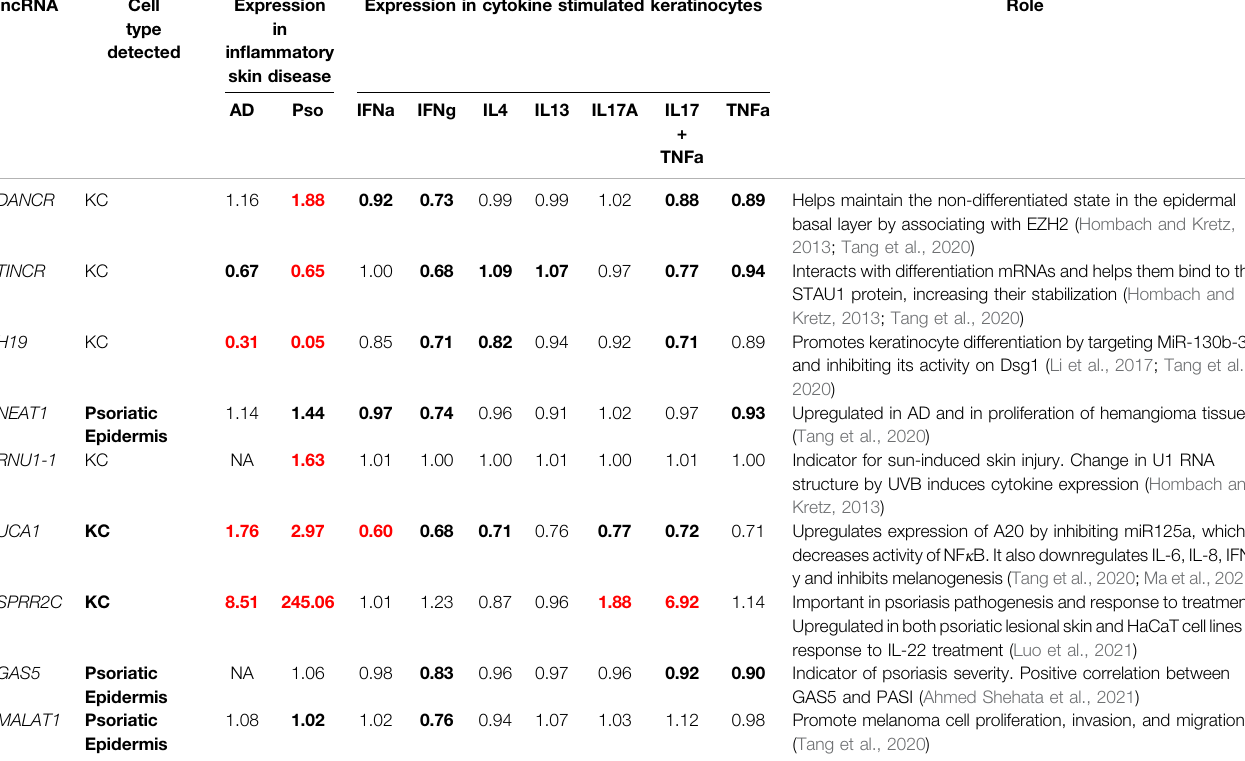
( Table 1 ; Supplementary Table S1 ). Using RNA sequencing, previous work has revealed that DANCR (anti-differentiation non-coding RNA) is signi fi cantly downregulated during terminal differentiation (Huarte et al., 2010; Kretz et al., 2012), and indicates its functional role in the transition from non- differentiated to differentiated cells (Huarte et al., 2010).